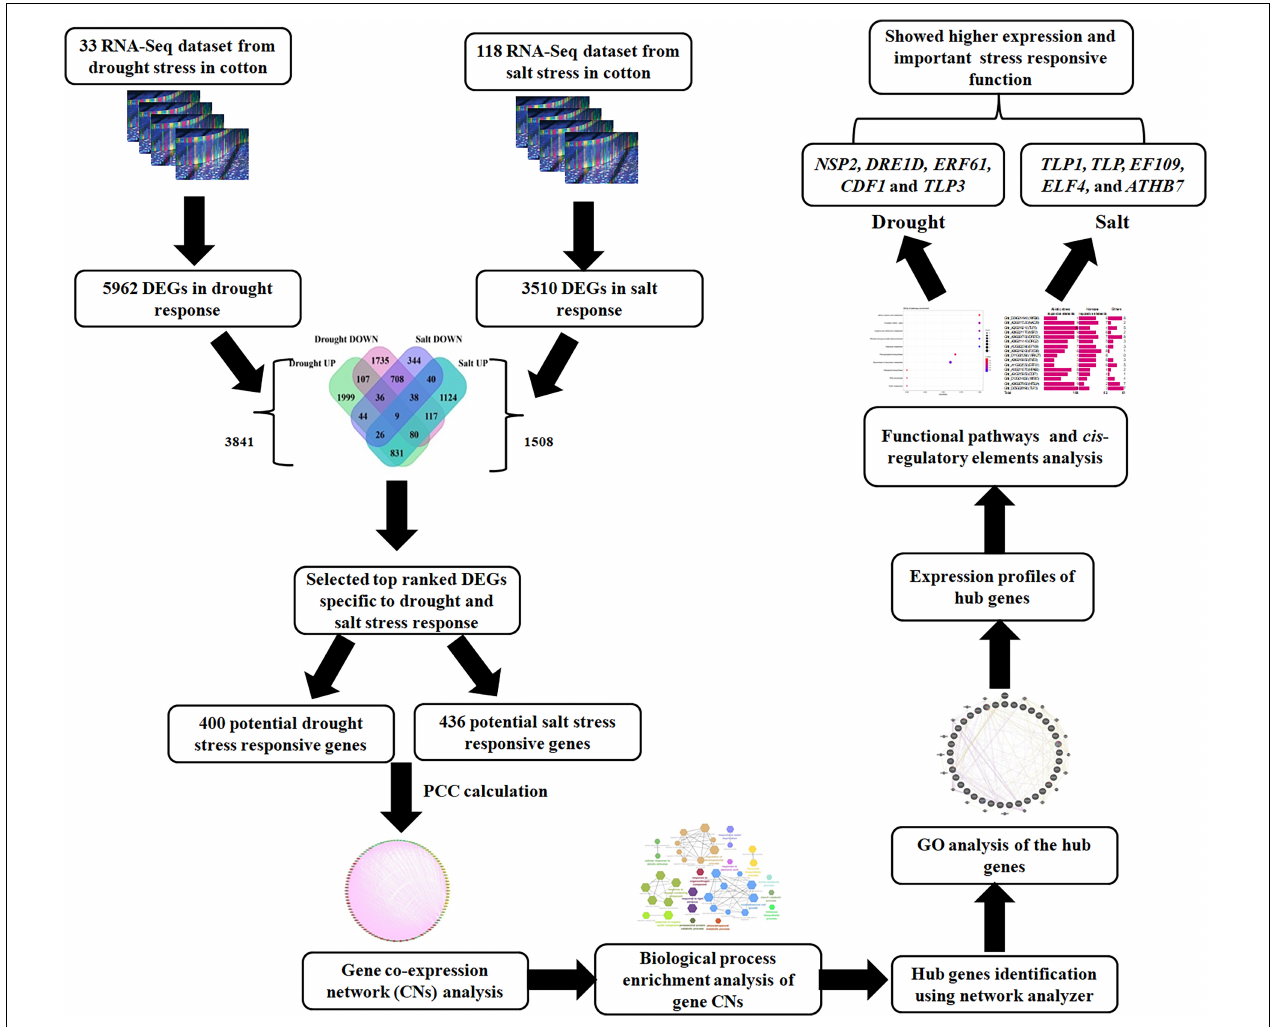
FIGURE 11 | The overall flow chart and strategy for designing and analyzing drought and salt stress-responsive